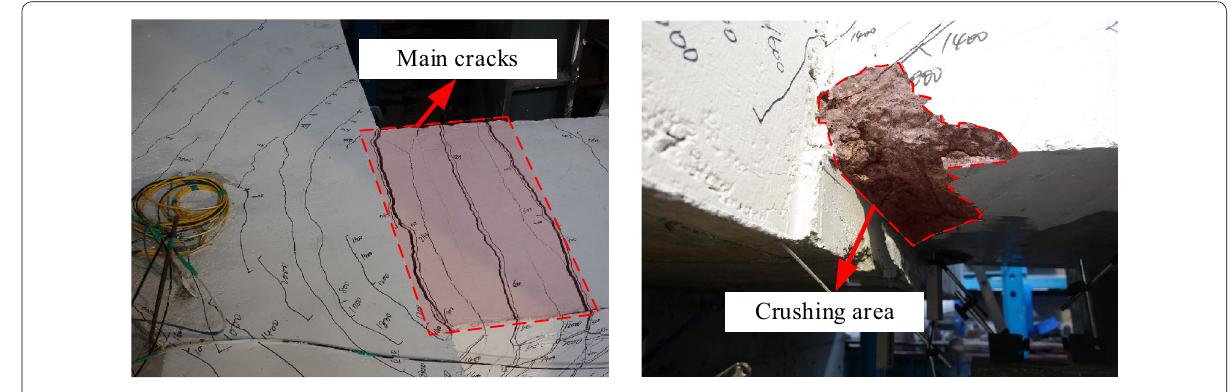
Fig. 9 Ultimate failure of the